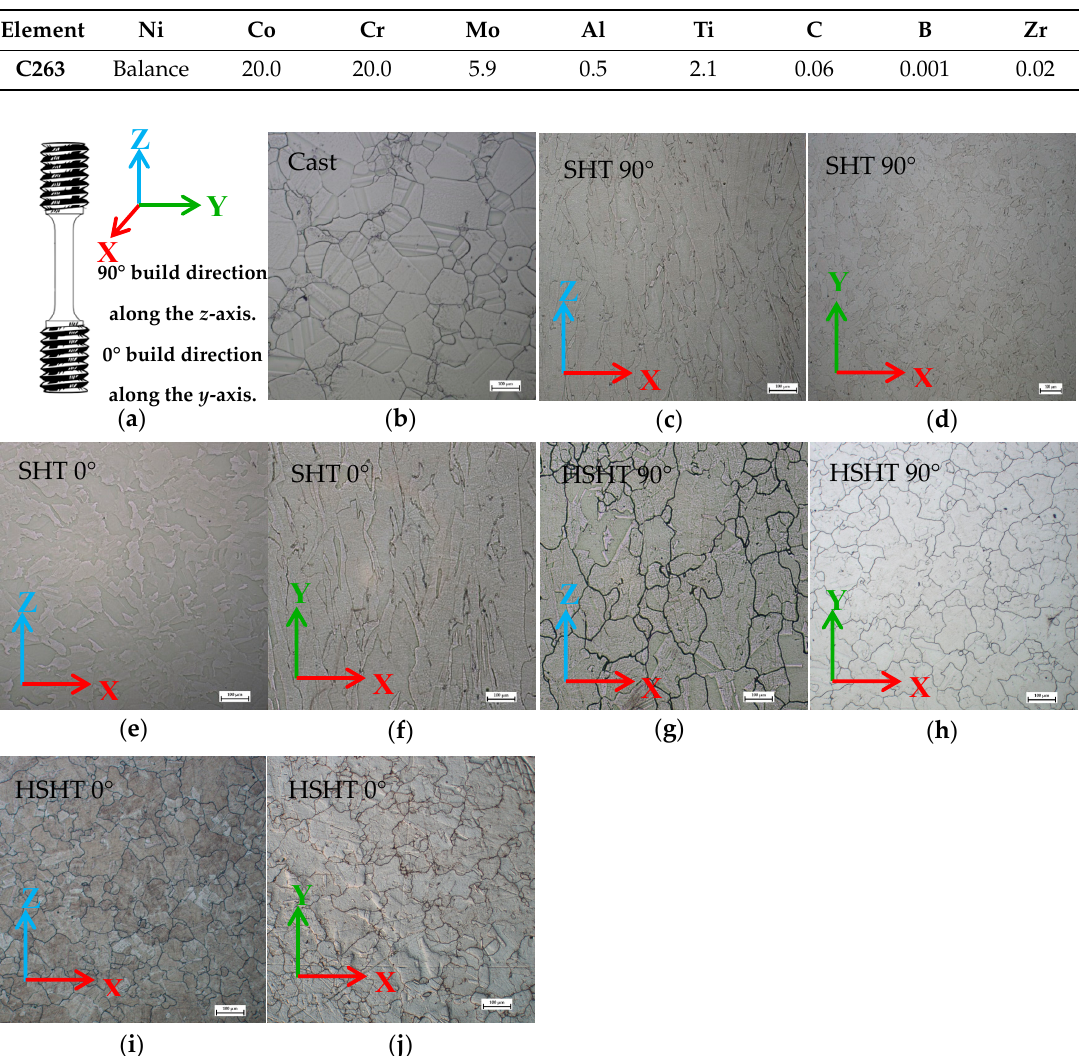
Table 1. Nominal alloy composition of C263 (wt %) [16].